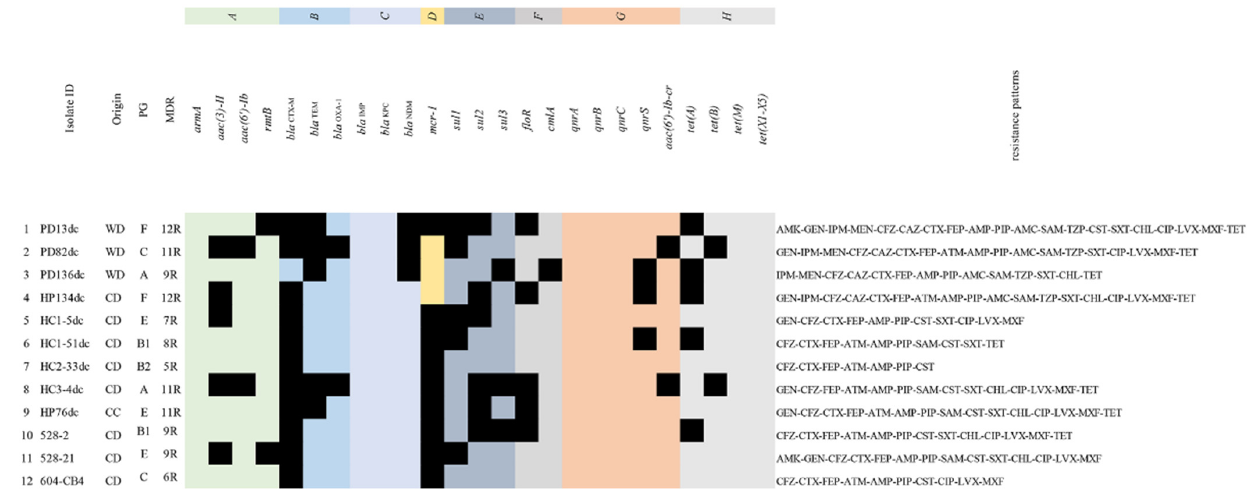
Figure 3. Resistance gene profiles and resistance patterns of 12 ESBL E. coli , which were resistant to carbapenems or colistin. Black squares indicate gene presence. A. Aminoglycoside resistance genes; B. bla ESBL ; C. carbapenem resistance genes; D. colistin resistance genes; E. sulfonamide resistance genes; F. chloramphenicol resistance genes; G. fluoroquinolone resistance genes; H. tetracycline resistance genes; WD. working dog; CD. companion dog; CC. companion cat; PG. phylogenetic groups.